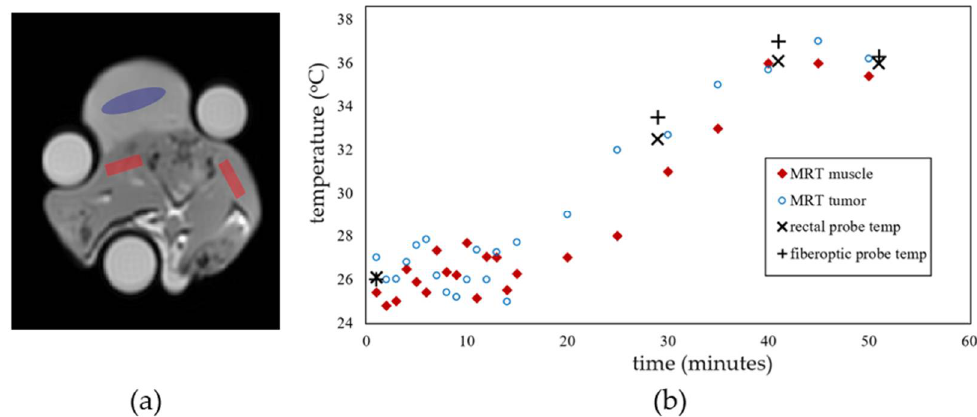
Figure 3. In vivo MR thermometry data and temperature probe data. ( a ) Axial slice through the center of a tumor grown on a rat flank. The elliptical ROI averages the MRT data in the tumor region, while the rectangular ROIs average MRT data in the muscle region. ( b ) Temperature change plots during warming cycle for muscle (diamond markers) and tumor (round markers) tissues. Plot also indicates rectal (body) and tumor temperature probe readings at various timepoints.